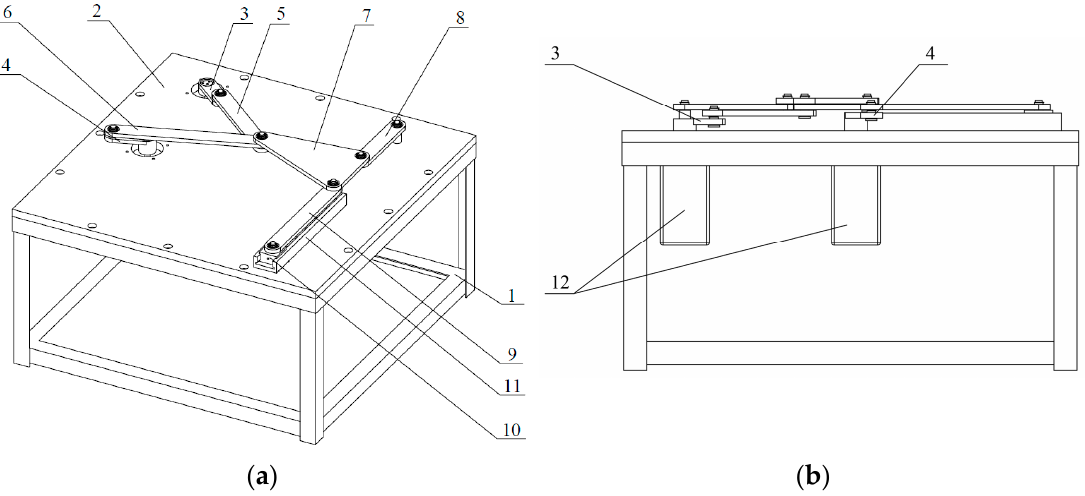
Figure 13. The 2- DOF nine–bar mechanism test bed. ( a ) Vertical view. ( b ) Lateral view.